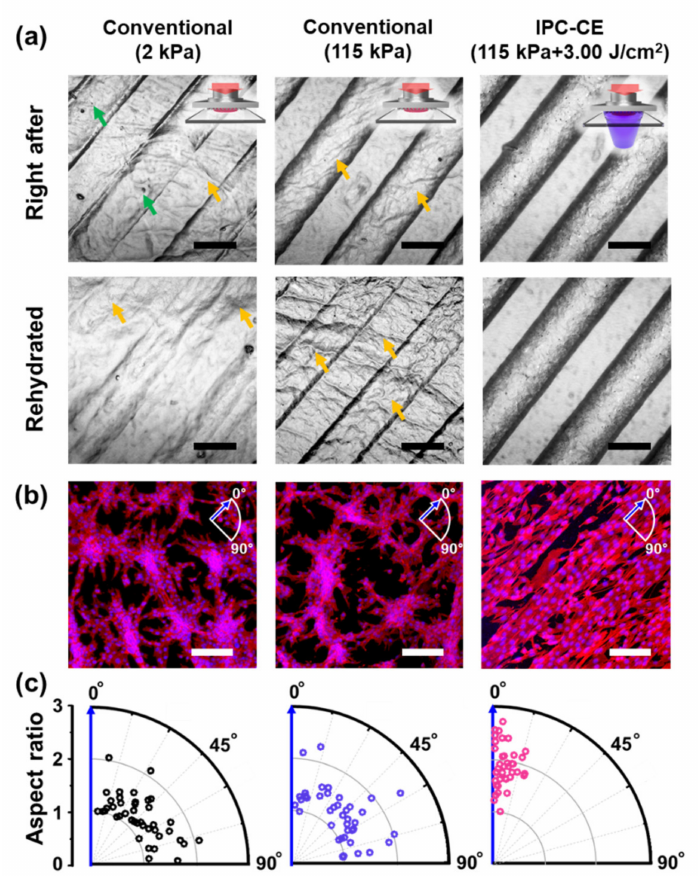
Figure 4. Robustness and topographical e ff ect of the IPC-CE construct. ( a ) Microscopic observation of conventional (2 and 115 kPa without UV dose) and IPC-CE construct, right after fabrication and after immersion in PBS solution. Green and yellow arrows indicate defects by partial replication and wrinkled structure, respectively. ( b ) NIH 3T3 cells cultured on each construct on day 2 (DAPI, blue; phalloidin, red). ( c ) Aspect ratio and orientation of NIH 3T3 cells. Blue arrow indicates direction of micro-ridge patterns. All scale bars are 100 µ